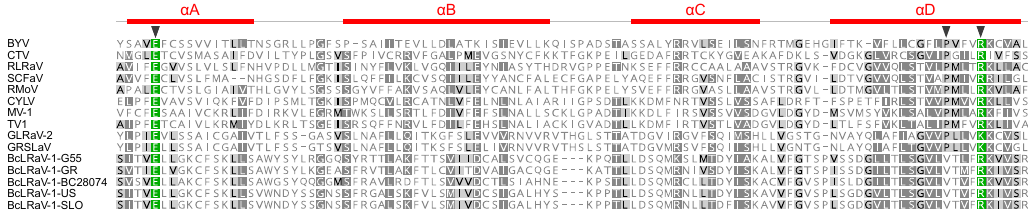
Figure 2. Multiple alignment of the Zemlya-region sequences of beet yellows virus (BYV, NC_001598), citrus tristeza virus (CTV, AB046398), rose leaf rosette-associated virus (RLRaV, NC_024906), strawberry chlorotic fleck-associated virus (SCFaV, NC_008366), raspberry mottle virus (RMoV, NC_008585), carrot yellow leaf virus (CYLV, NC_013007), mint virus 1 (MV-1, NC_006944), tobacco virus 1 (TV1, NC_027712), grapevine leafroll-associated virus 2 (GLRaV-2, NC_007448), grapevine rootstock stem lesion-associated virus (GRSLaV, NC_004724), BcLRaV-1-G55 (MH460557), BcLRaV-1-GR (MH460558), BcLRaV-1-BC28074 (MH541840), BcLRaV-1-US (MH500053), and BcLRaV-1-SLO (MH480582). Gaps are shown as dashes. Black triangles indicate conserved positions. Previously predicted [25] secondary structure is shown above the alignment.